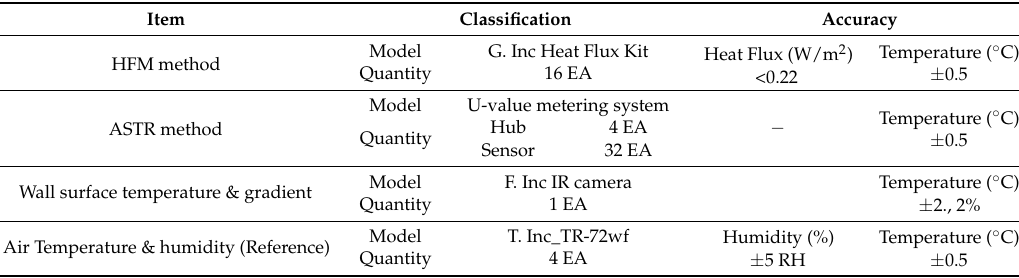
Table 5. Overview of measurement